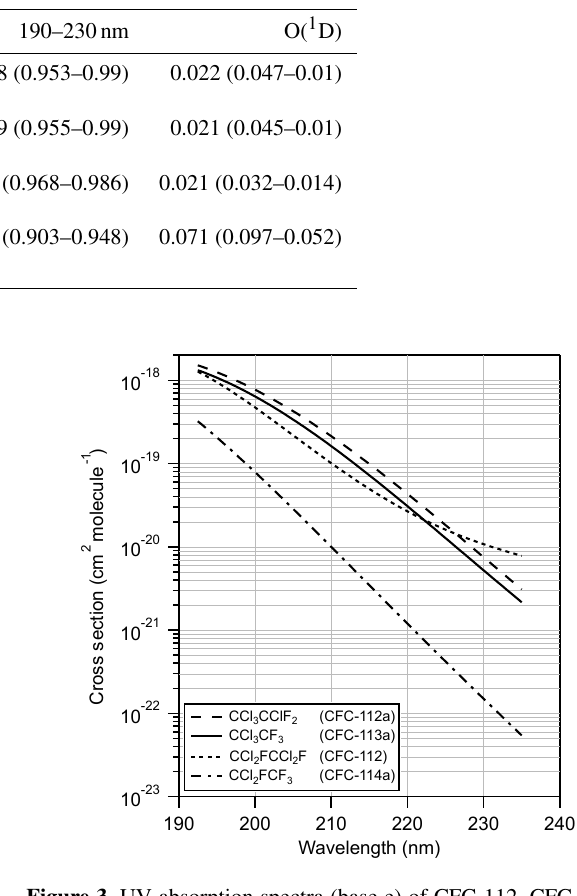
Figure 2. CCl 2 FCF 3 (CFC-114a) UV absorption spectrum (base e) and parameterization obtained in this work. Cross section data (symbols, Table 2) and the parameterization of the data using the empirical formula and parameters given in Table 3 (see text). The lower frame shows the overall quality of the parameterization.